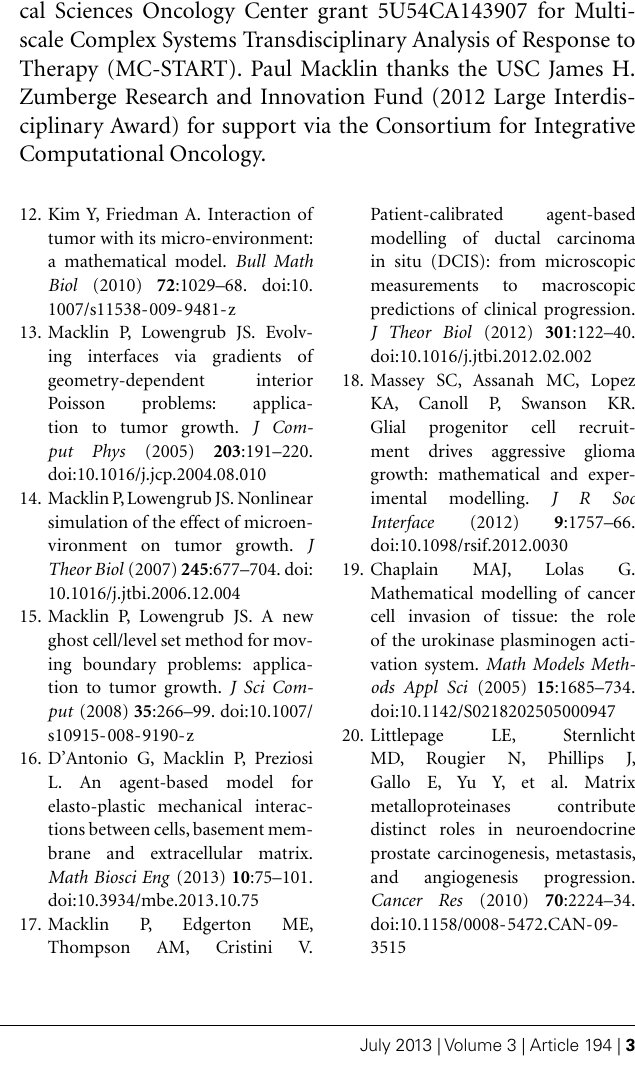
FIGURE 1 | Top left: initial configuration of epithelium (white lumen and tumor cells), a 100nm basement membrane, stroma (orange), and stromal cells (red) that secrete MMPs. Remaining plots: ECM volume fraction [ranging from